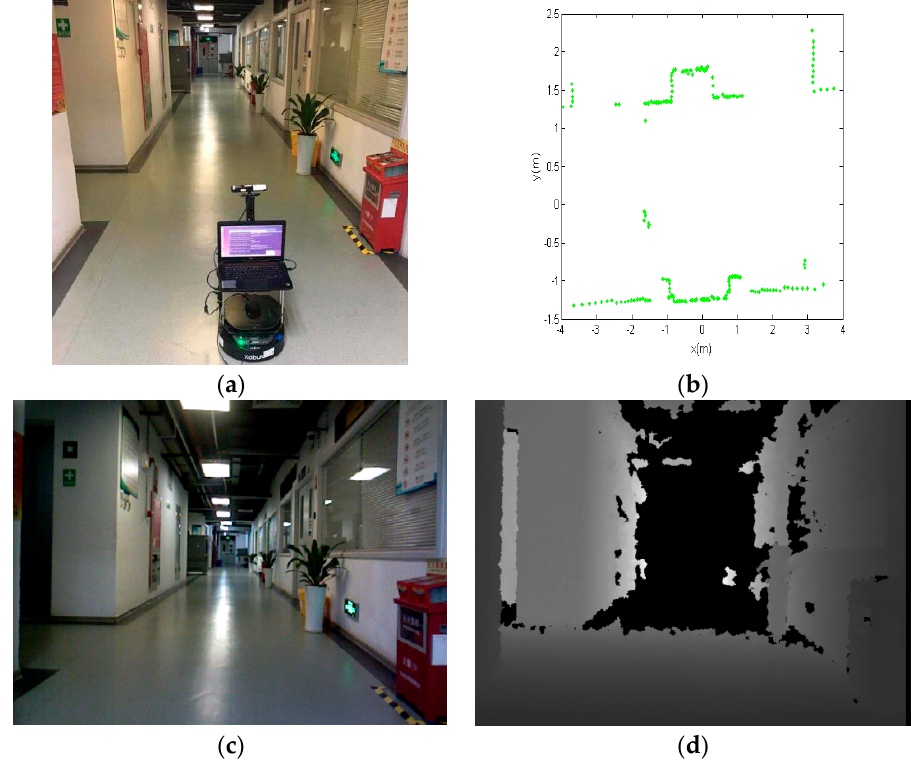
Figure 7. One example of the database: ( a ) The robot in the environment; ( b ) scan data obtained in the